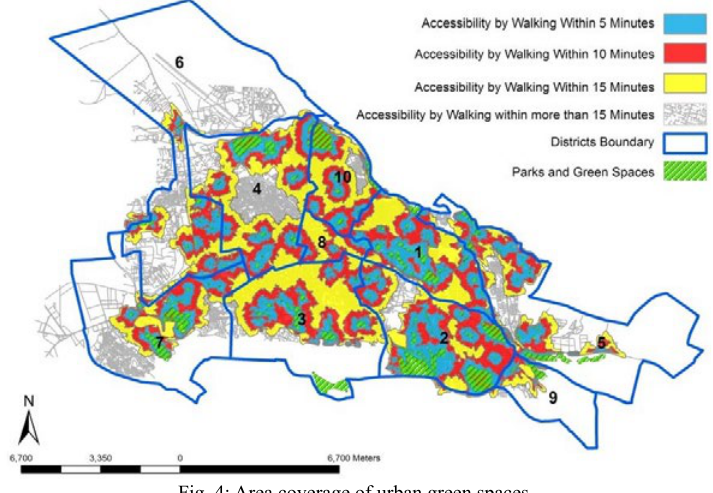
Fig. 4: Area coverage of urban green spaces Fig 4: Area coverage of urban green spaces